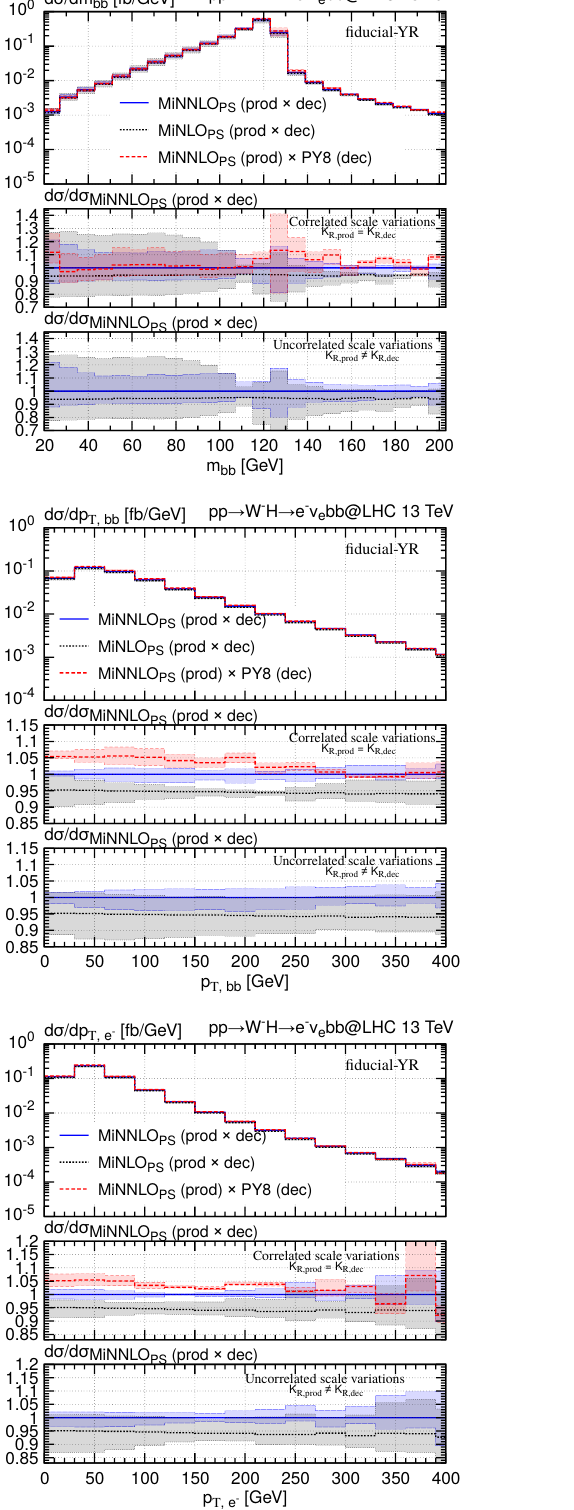
Figure 8 . Differential distributions for e − ¯ νb ¯ b production with fiducial-YR cuts. K R , prod and K R , dec refer to the variation factors of the renormalization scales of production and decay,